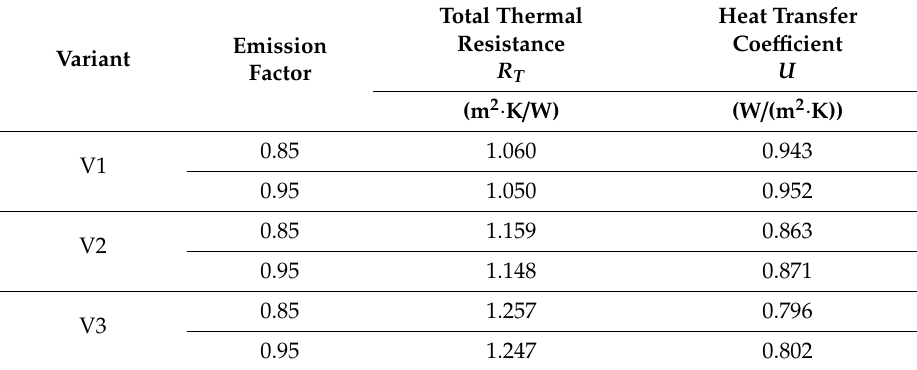
Table 5. Results obtained by the numerical simulation method (NSM).